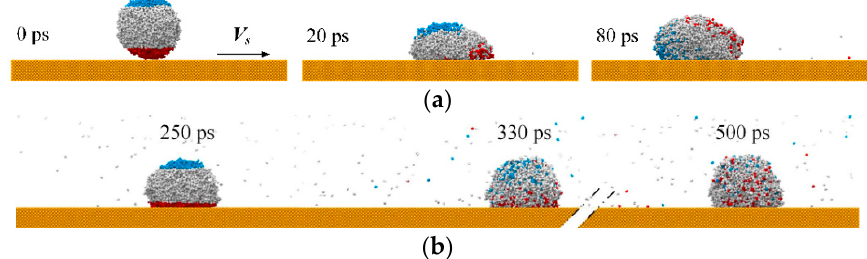
Figure 6. Different motion mechanisms of water molecules inside the water nanodroplet at two stages: ( a ) relative sliding stage; ( b ) stable stage.